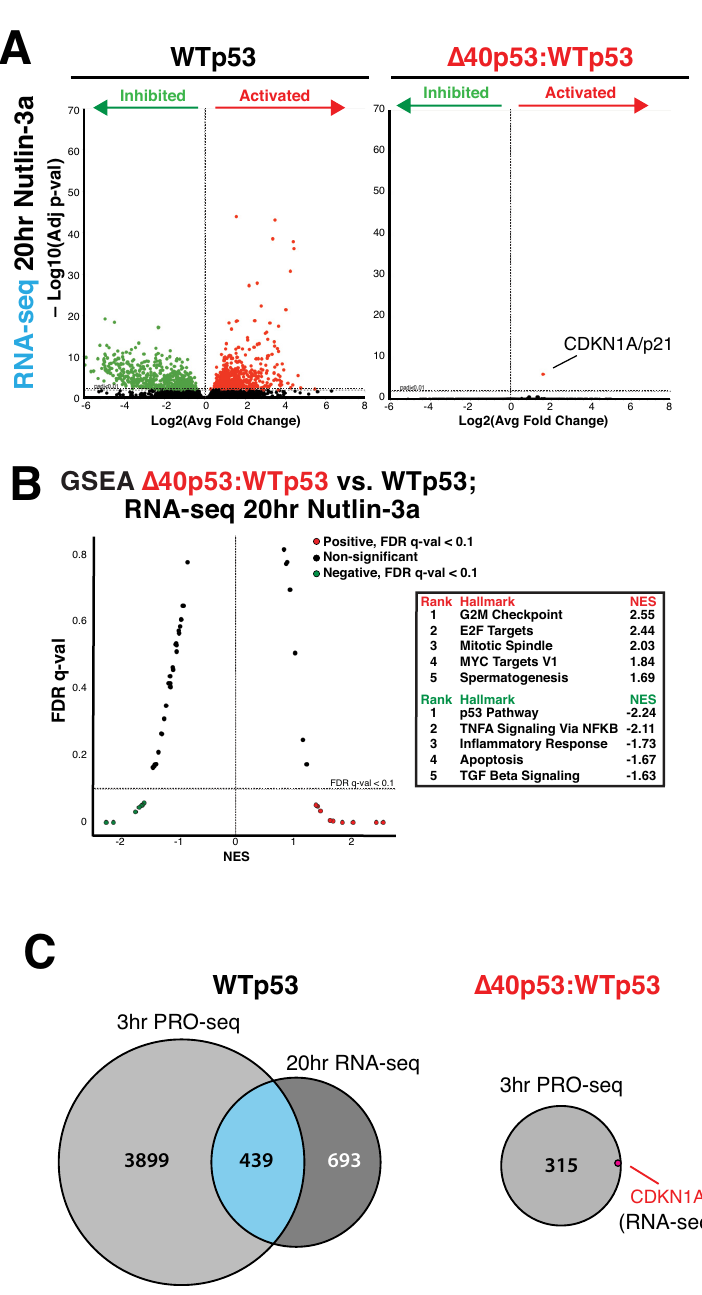
Fig 3. p53 activation fails to increase mRNA levels in Δ 40p53:WTp53 cells. (A) Volcano plots showing differentially expressed mRNAs after 20-hour Nutlin treatment (vs. DMSO controls) in WTp53 or Δ 40p53:WTp53 cells. Green dots represent down-regulated and red dots up-regulated transcripts ( p -val � 0.01). ( B) GSEA based upon RNA-seq data (20 hours Nutlin-3a) comparing Δ 40p53:WTp53 vs. WTp53. Pathways with FDR q-val < 0.1 are colored dots. Red represents increased in Δ 40p53:WTp53 compared to WTp53, and green is decreased. X-axis is NES. Top significant pathways are shown in ranked list. (C) Venn diagrams showing overlap among significantly induced transcripts from PRO-seq data (3 hours Nutlin) and RNA-seq data (20 hours Nutlin). Whereas about 10% of nascent transcripts show corresponding increases at the mRNA level in WTp53 cells, only CDKN1A/p21 shows this behavior in Δ 40p53:WTp53 cells (1/316; 0.3%). Raw data for panels A and B in S3 Data . FDR, false discovery rate; GSEA, gene set enrichment analysis; NES, normalized enrichment score; PRO-seq, precision nuclear run-on sequencing; RNA-seq, RNA sequencing; WTp53, wild-type